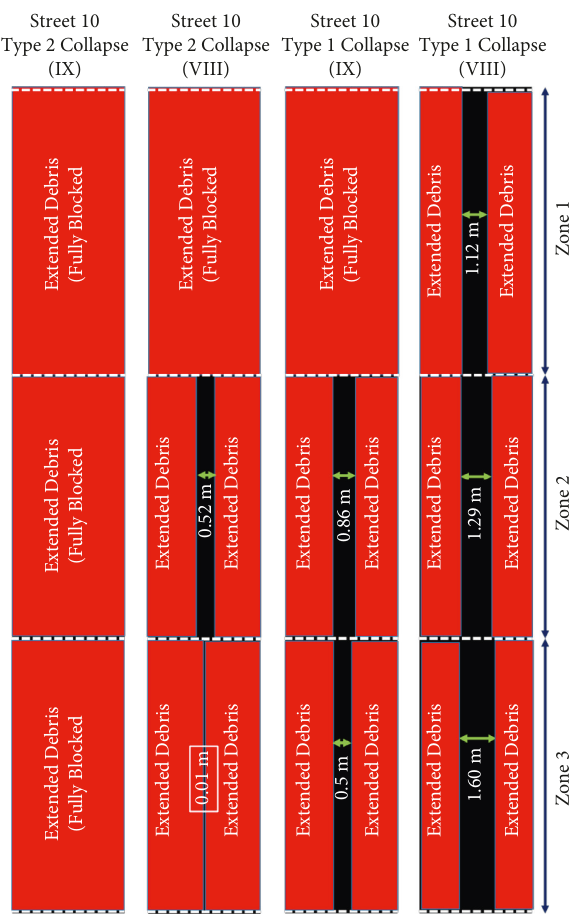
Figure 11: Representative figure for the obstructed zones of street number